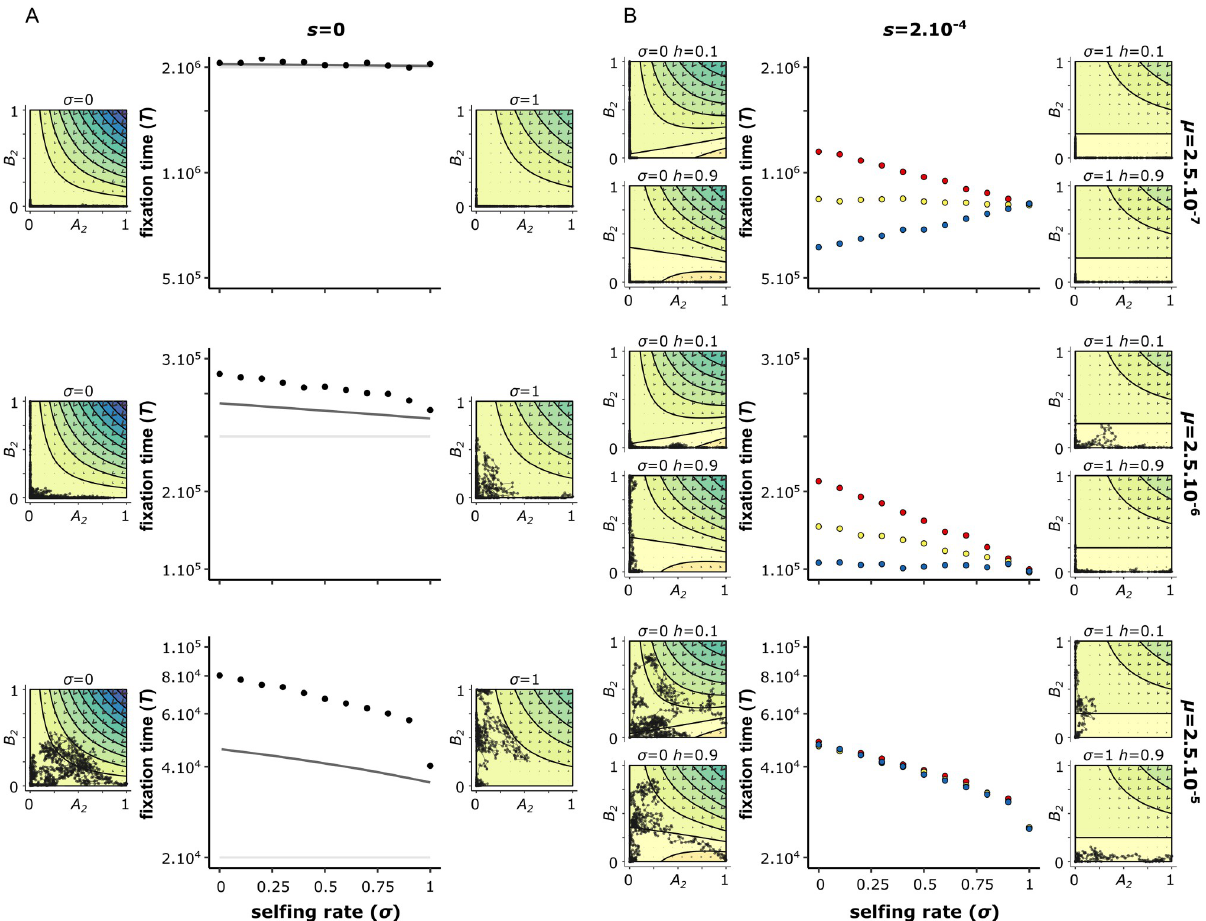
Fig 6. Selfing rate accelerates the fixation of BDMi mutations for high mutation rates. The fixation time estimated from the two loci models with mutation rates ( μ ) for A 2 and B 2 of either 2.5.10 − 7 (top), 2.5.10 − 6 (middle), or 2.5.10 − 5 (bottom), and the strength of selection on the derived alleles ( s ) is either 0 (left), or 2.10, − 4 (right). When there is selection, the dominance coefficient ( h ) is either recessive ( h = 0.1, red), co-dominant ( h = 0.5, yellow), or dominant ( h = 0.9, blue). The solid lines in the neutral scenario correspond to analytical approximations: 1/2 μ (light grey), and Eq (17) (dark grey) (see BDMi Results section for details on the approximations). Each phase portrait shows, for a single simulation, the change in allele frequencies of A 2 and B 2 plotted from the beginning, and then every 100 generations until the fixation of a derived allele. The isoclines represent the expected benefits (warm colours) and costs (cold colours) on population fitness (multiplied by N , and with a increment of 1). The direction of the arrow indicates the expected e allele change (which is the balance between mutation rates and selection), and their size indicates the strength of the change. N = 10, 000, h b = k b = 0.5, s b = 10 − 3 , r = 0.5. 10, 000